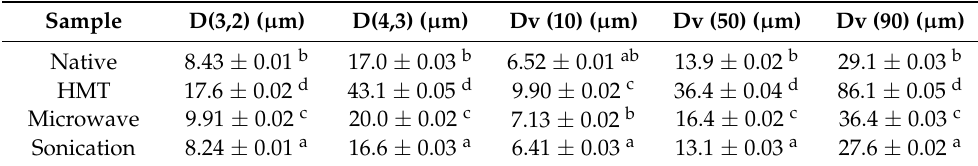
Table 5. Particle size distribution of native and modified